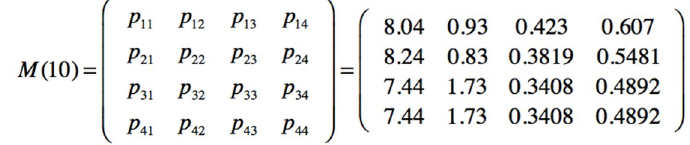
Figure 33. Number of visits for the posterior transition matrix.